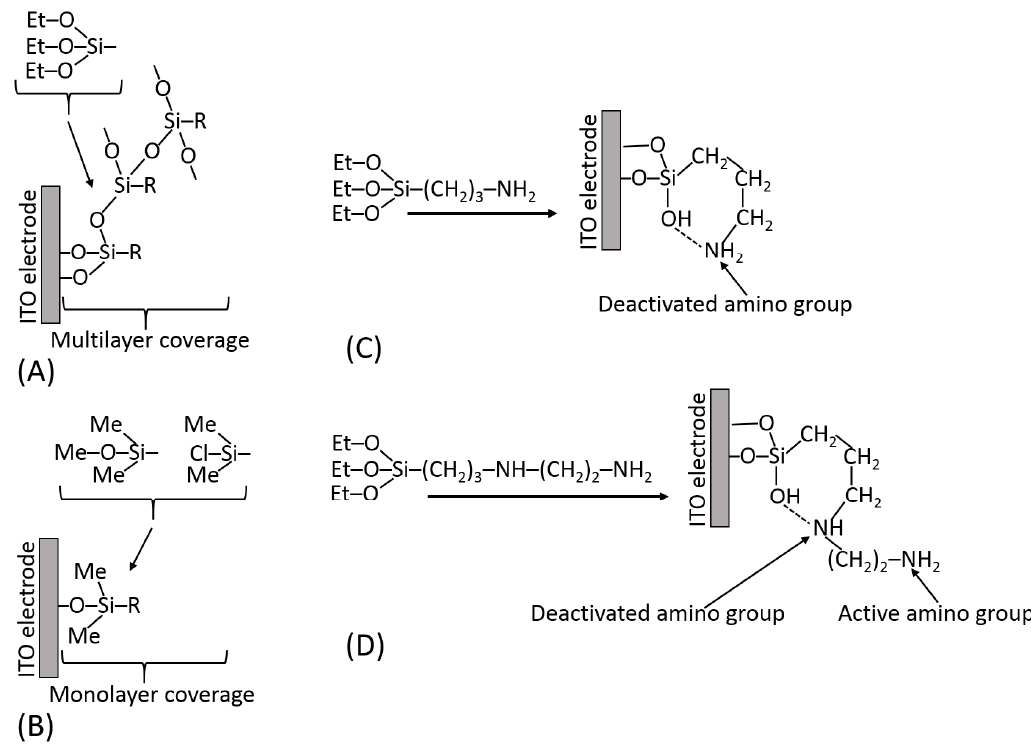
Figure 14. ( A ) Multilayer coverage of an ITO electrode upon silanization with a silane with three hydrolyzable groups performed in protonic solvents (e.g., ethanol) or in aprotic solvents (e.g., toluene) with traces of water. ( B ) Strictly monolayer coverage of an ITO electrode using silane with one hydrolyzable group. ( C ) Deactivation of the terminal amino group upon formation of a cyclic structure in the silane layer. ( D ) Preserving an active terminal amino group in the silane layer with two amino groups in the silane molecule.